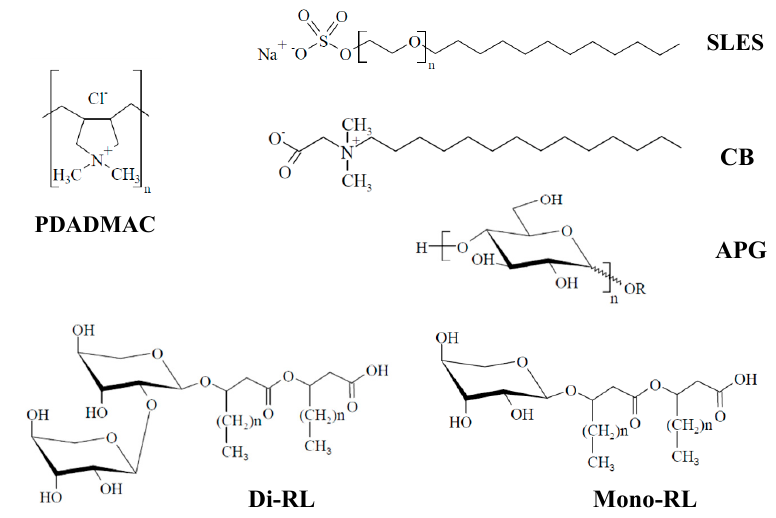
Figure 1. Molecular structures for the polyelectrolyte and the surfactants used in this study, n for SLES assumes a value of 5 and for APG, di-RL, and mono-RL a value of 10.